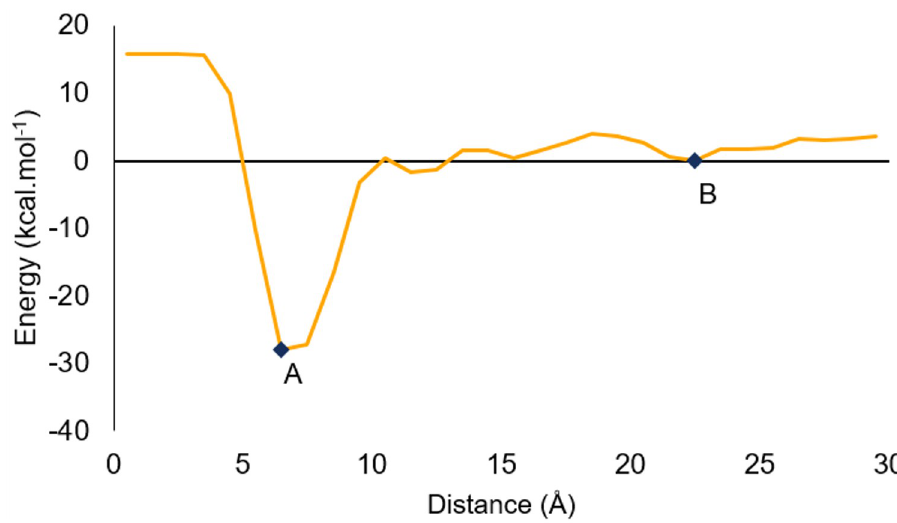
Fig 5. Energy profile for M pro -mirabegron in its first replica with CHARMM and the first CV set. The points A and B represents, respectively the minimum energy inside the active site and in the water.